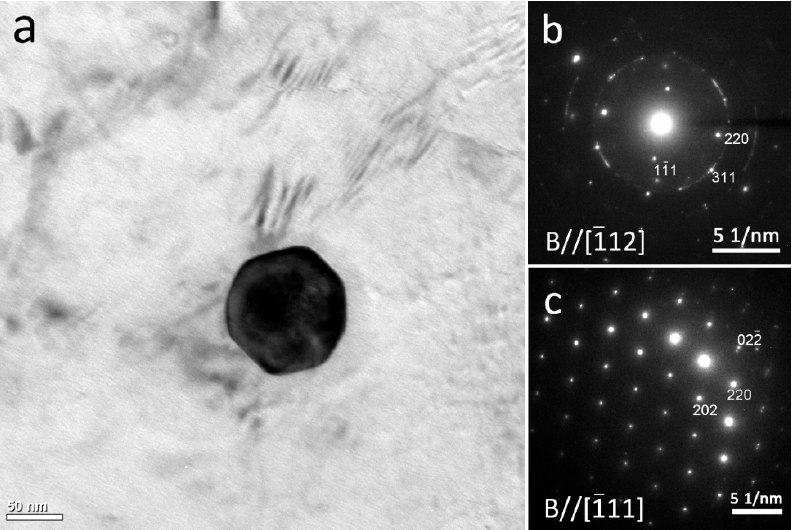
Figure 11. The bright field TEM micrograph of the nanoscale phase observed in as-extruded Mg–4Sm–2Zn–0.5Zr alloy for ( a ), and corresponding SAED patterns taken along the [1(cid:3364)12] direction for ( b ) and the [1(cid:3364)11] direction for ( c ).